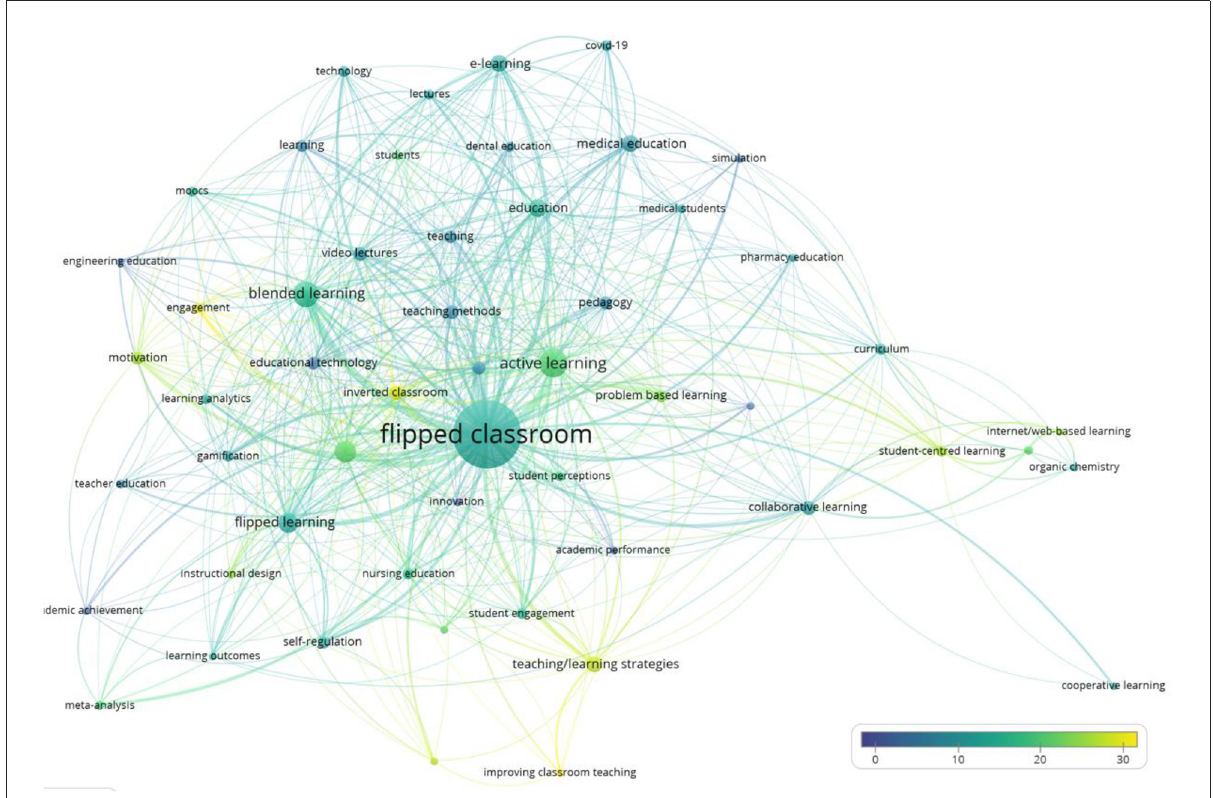
FIGURE8 Map according to number of citations. Source: Created by authors with